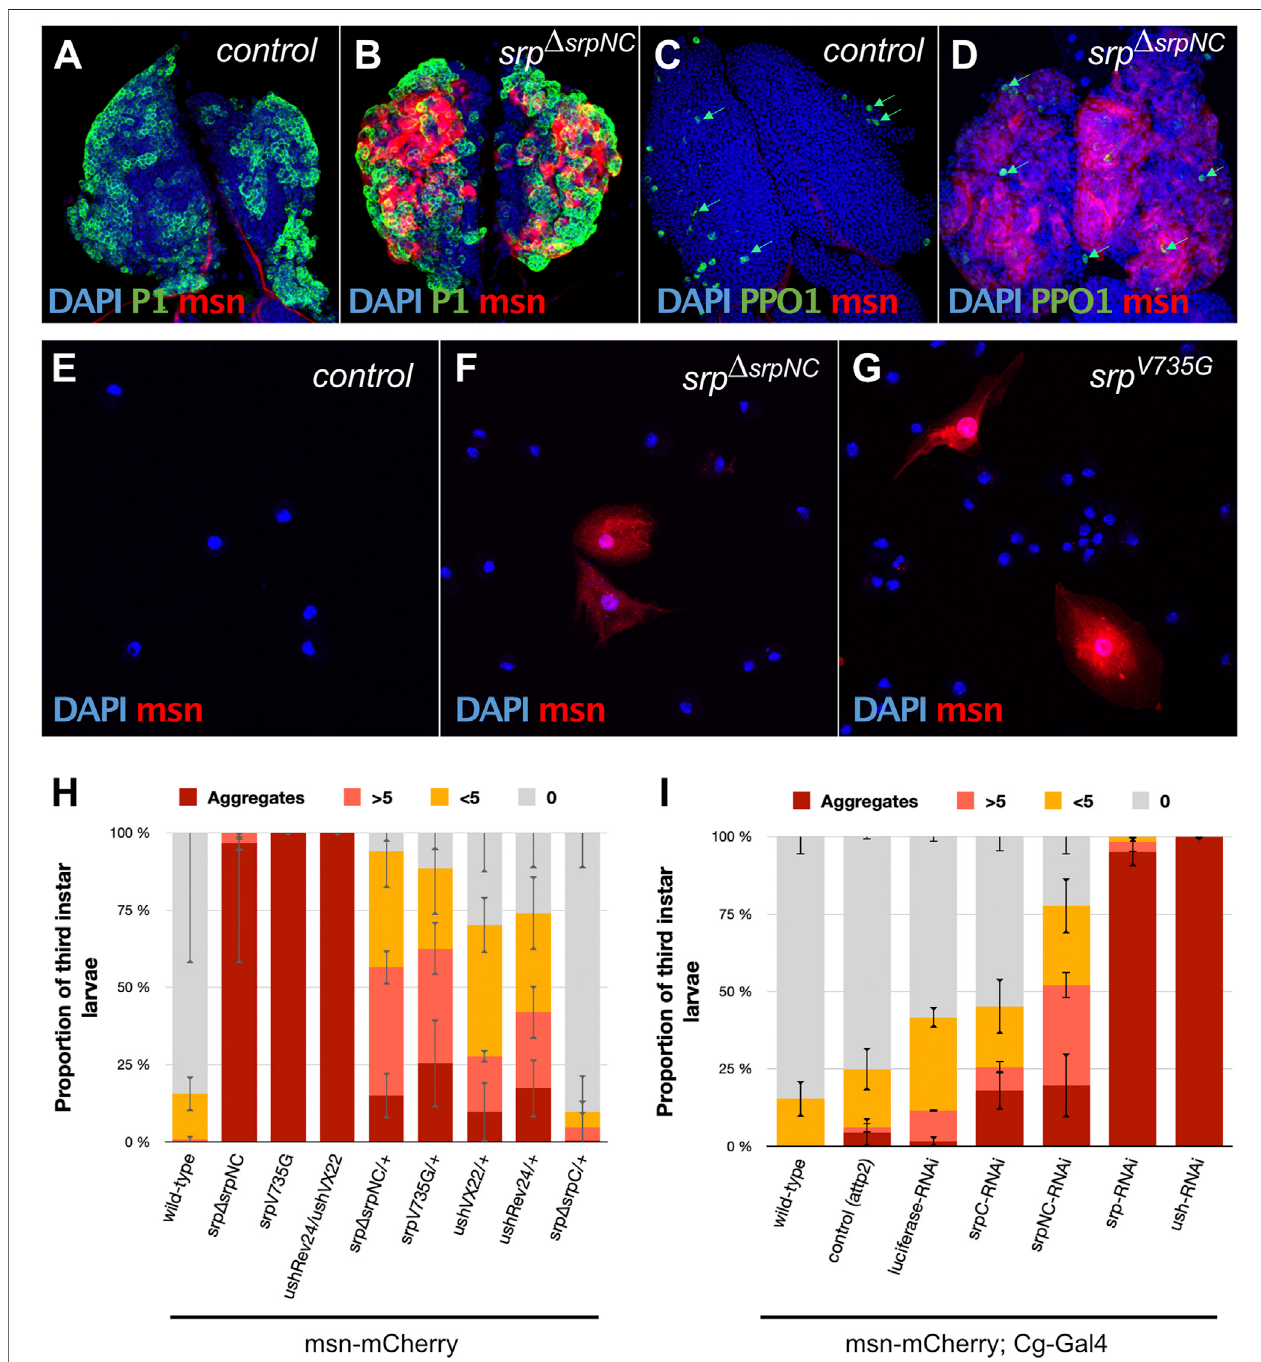
FIGURE 5 | SrpNC/Ush interaction is required to inhibit lamellocyte formation during larval hematopoiesis. Immunostaining against the plasmatocyte marker P1 (green, (A,B) ),thecrystalcellmarker prophenoloxidase1 ( PPO1 ,green, (C,D) )andthelamellocytespeci fi cmarker( msn-mCherry ,red, (A – G) )inlymphglands (A – D) and blood cells of hemolymph of third instar female larvae (E – G) . Nuclei are stained with DAPI (blue). Lamellocytes are detected in both lymph glands (B,D) and the hemolymph of srp Δ srpNC mutant larvae (F) and in srp V735G mutant larvae (G) . (H,I) Hemolymph analysis of third instar larvae using the lamellocyte speci fi c marker msn-mCherry ( n ≥ 40 except for srp V735G mutant larvae where n (cid:1) 25). 100% stacked bar charts showing percentage of larvae exhibiting zero (0), very few ( < 5), a remarkable number ( > 5) or aggregates of lamellocytes in their hemolymph. Homozygote mutant larvae, as well as the combination of amorphic ( ush VX22 ) and hypomorphic( ush Rev24 )alleles,displaystronglamellocyteproduction (H) .In srp Δ srpNC / + and srp V735G / + heterozygotelarvae,lamellocytesaredetectedtoalesserextent, except for srp Δ srpC /+ that exhibits no signi fi cant difference with the wild-type control. Using the Collagen driver ( Cg-Gal4 ), downregulation of both srp isoforms or ush leads to massive lamellocyte production. More than 75% of downregulated srpNC ( srpNC- RNAi) shows lamellocyte production, while less than 50% of downregulated srpC ( UAS-srpC- RNAi) does. Error bars correspond to mean deviation.